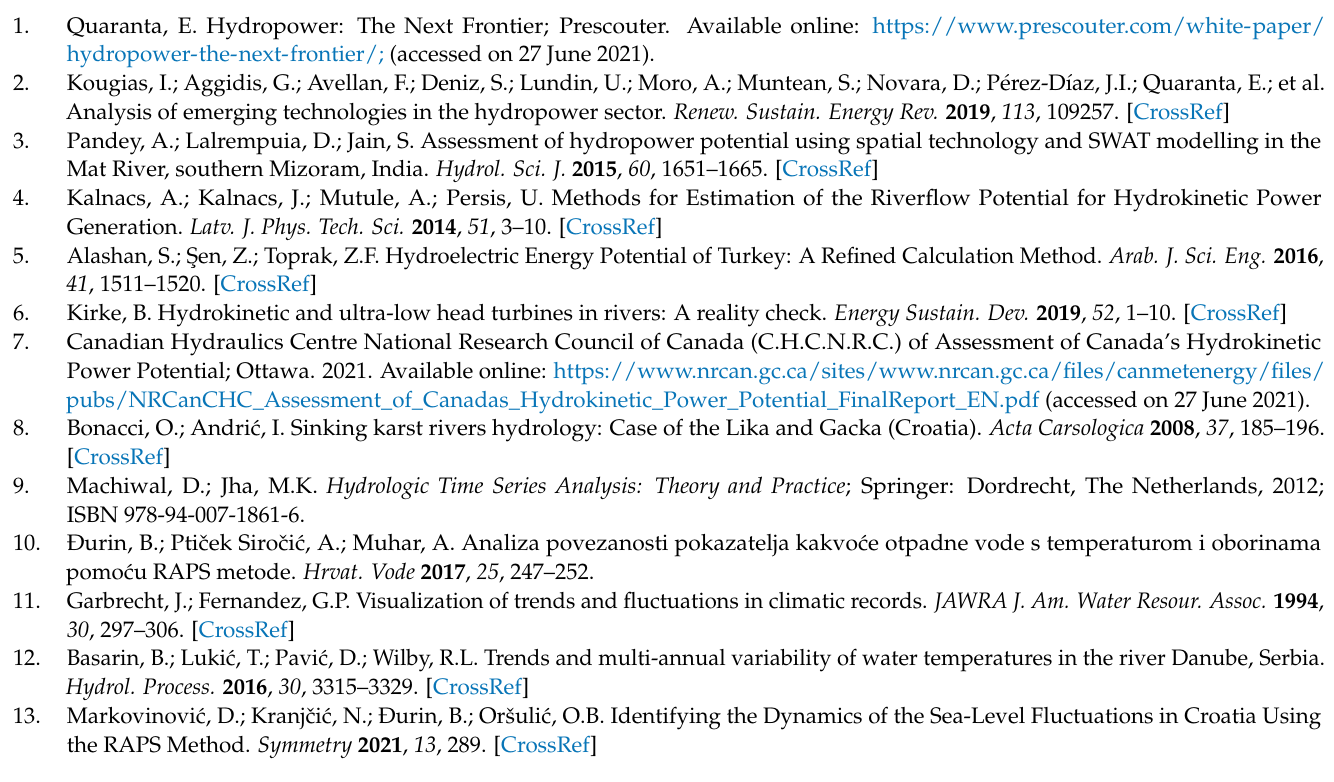
Figure A3. View at the location of the measuring station Motovun on the Mirna River.